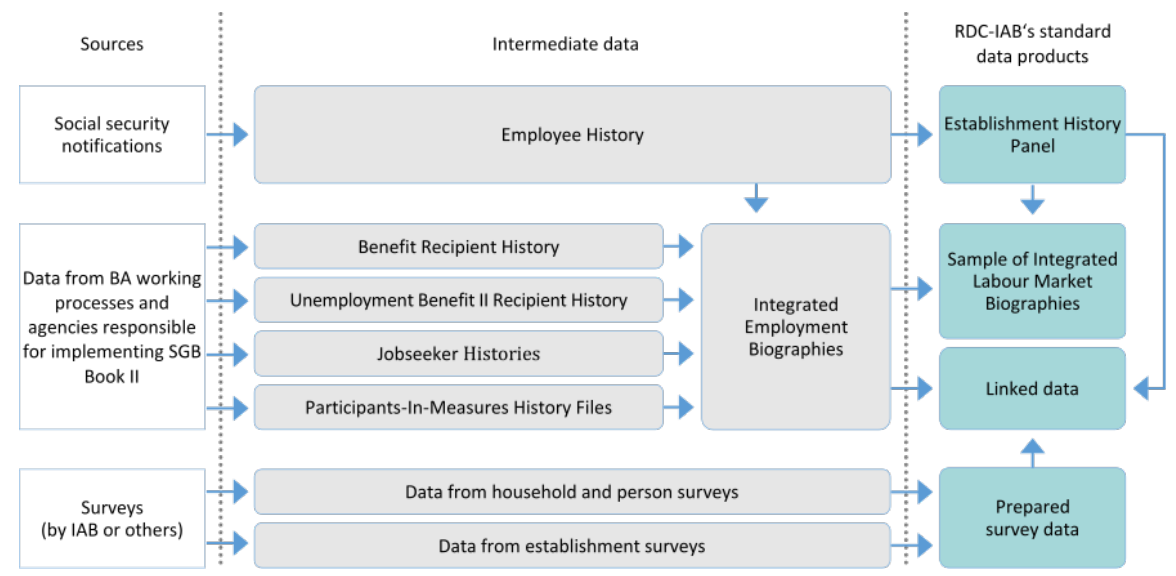
Figure 1: Sources and development of RDC-IAB’s standard data